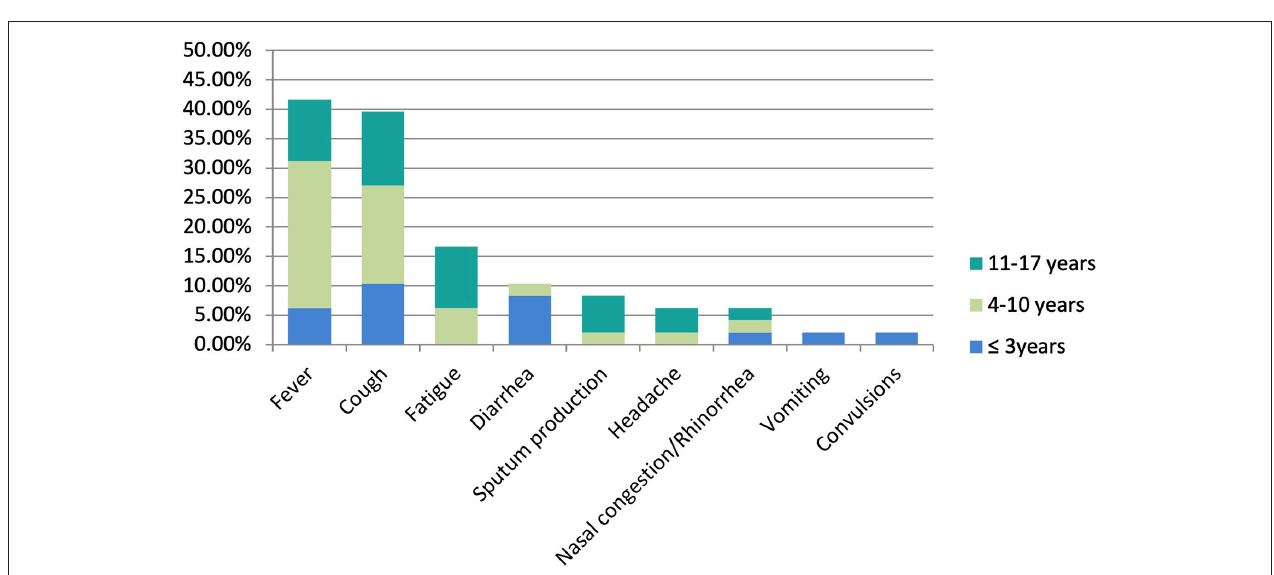
FIGURE 1 | Bar plot of percentage of the symptom presentation in different age